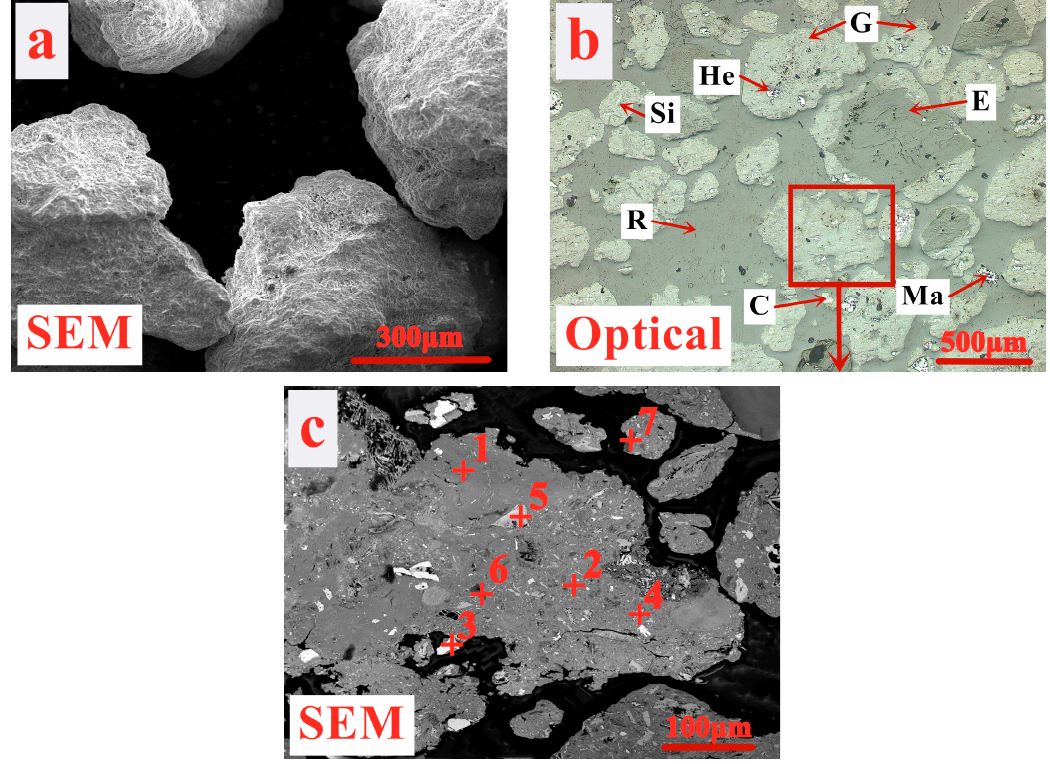
Figure 1. The mineralogy of limonitic nickel laterite (G—Goethite, He—Hematite, Ma—Maghemite, E—Enstatite, Si—Stishovite, C—Chromite spinel, R—Resin). ( a ) Morphology photograph, ( b ) Optical photograph, ( c ) SEM analysis photograph. Table 1. Energy dispersive spectrum (EDS) analysis results for areas in Figure 1. Area